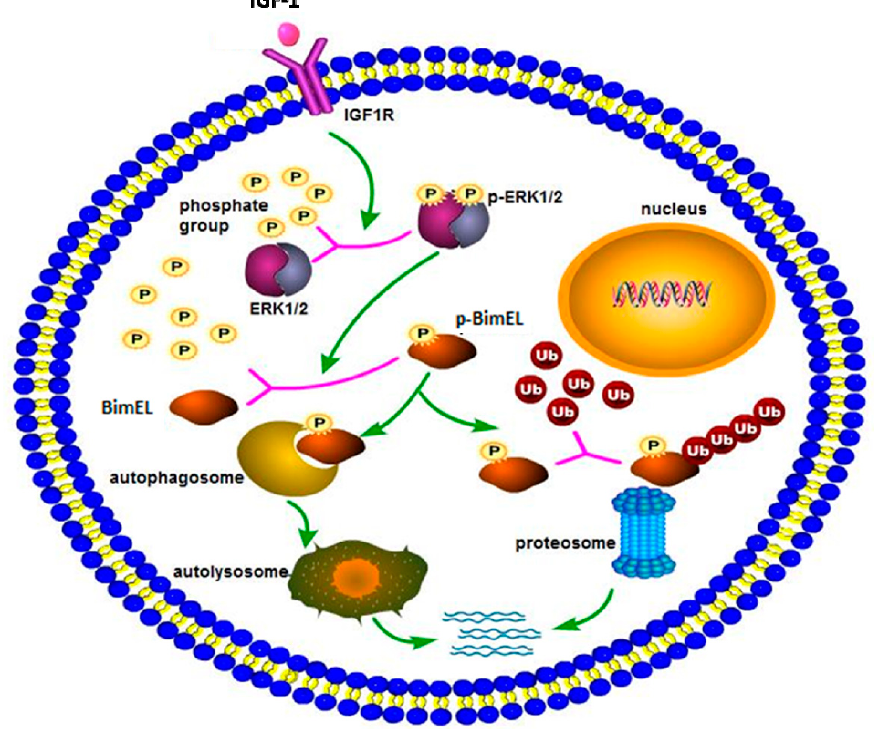
Figure 4. The schema diagram of IGF-1-induced Bim EL degradation. IGF-1, combined with its receptor, spurred a series of downstream cascade reactions in porcine primary granulosa cells. IGF-1 activated the ERK1 / 2 pathway, which caused posttranslational phosphorylation modification of Bim EL . Modified Bim EL was degraded by autophagy and the proteasome pathway, respectively.